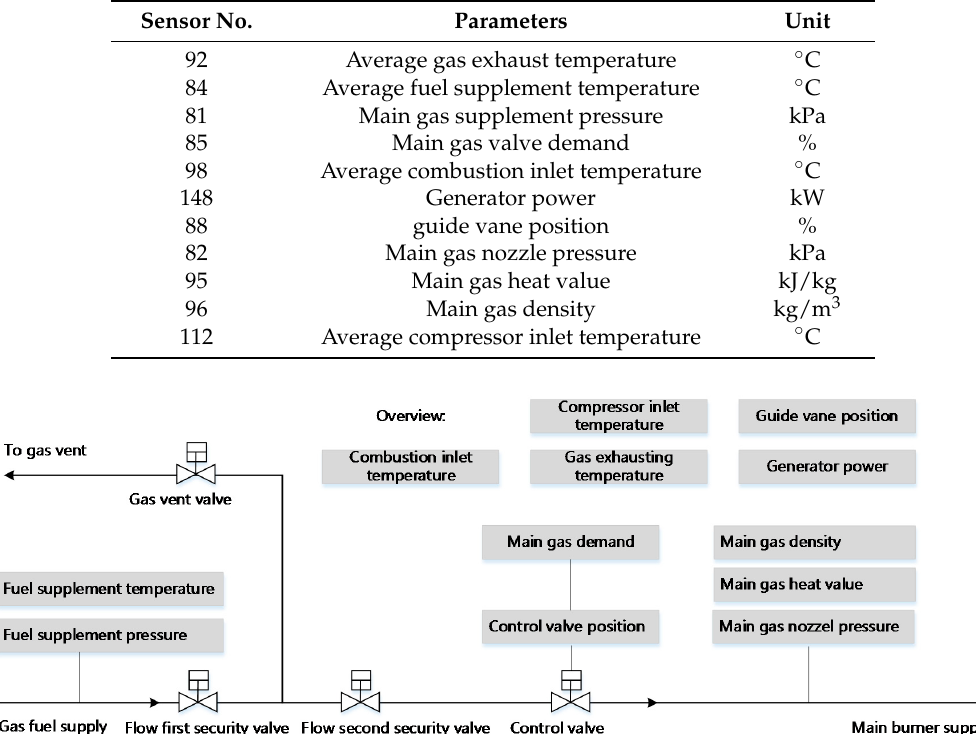
Table 2. Monitoring sensors used in symbol extraction.